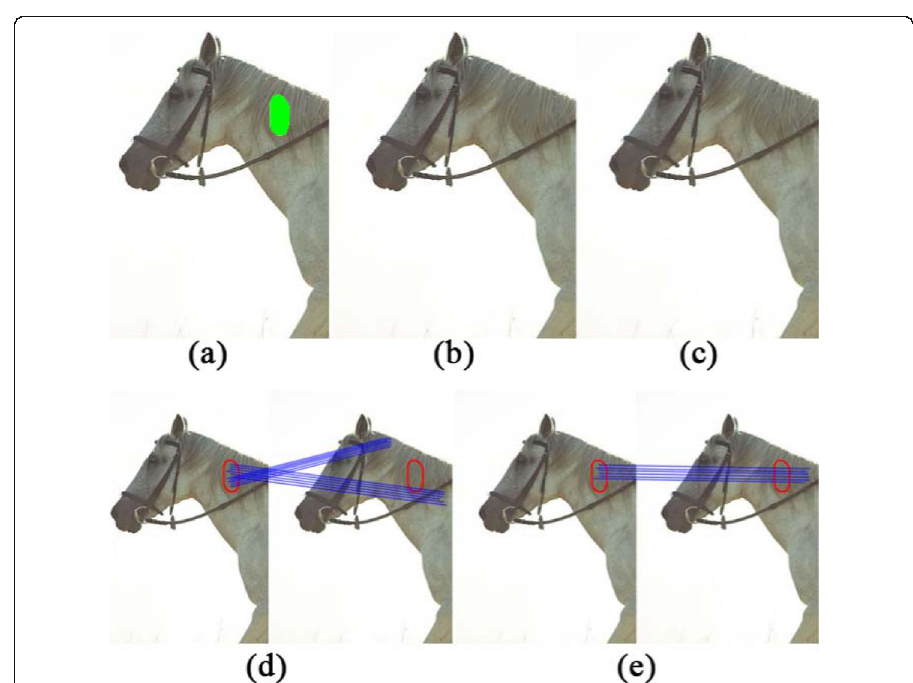
Fig. 4 Gradient for image completion. a Damaged image. b Result of PatchMatch. c Our result. d Finding the most similar patches without gradient. d Finding the most similar patches with